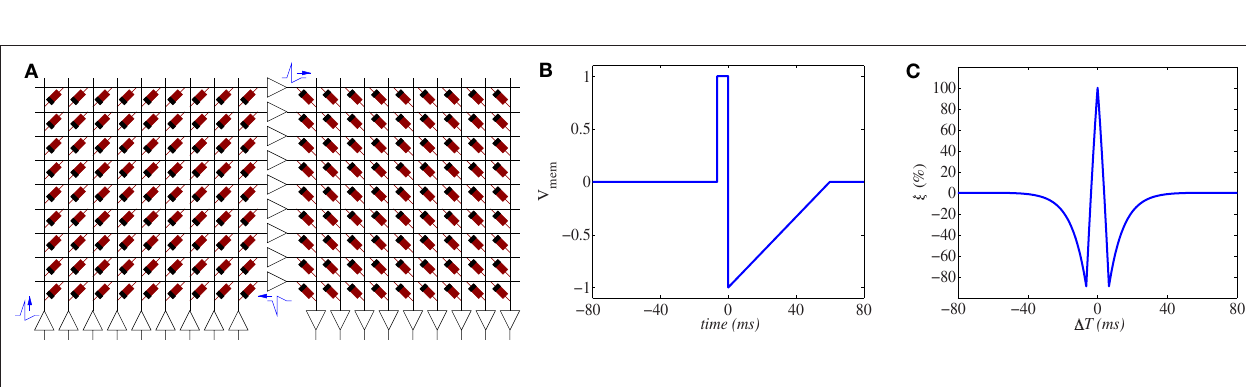
Figure 14 | Memristor connections for anti-STDP learning. (A) Using positive action potentials with negative net waveform area as in Figure 8A resulting in synapses delivering net negative charge packets. (B) Using inverted action potentials with positive net waveform area as in Figure 8B resulting in synapses delivering net positive charge packets.